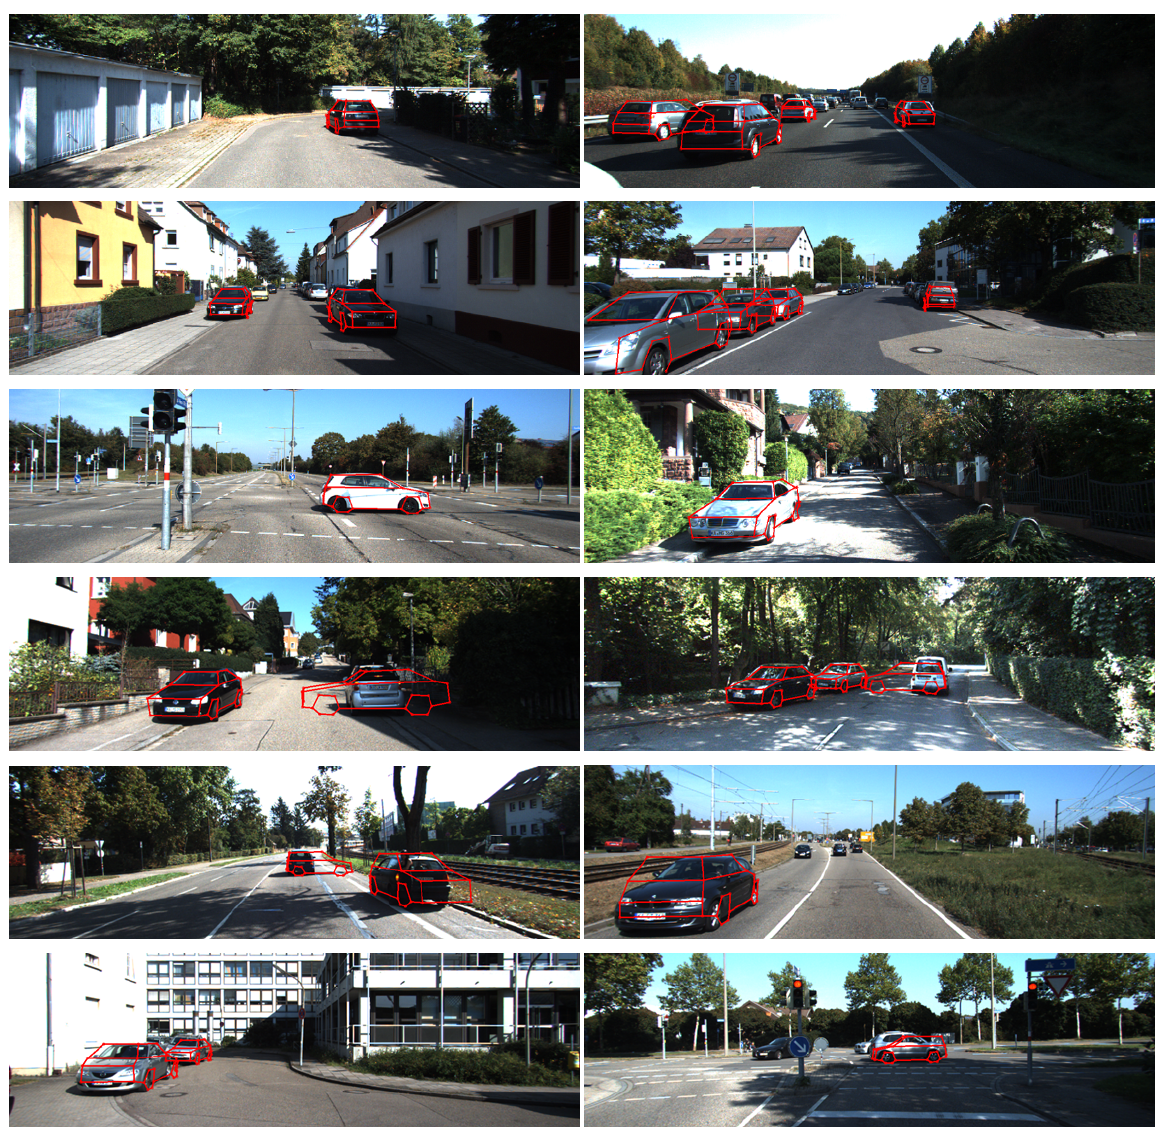
Figure 5. Qualitative results: backprojected wireframe of the fitted vehicle models. First three rows: positive examples, last three rows: typical examples of